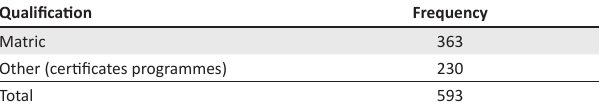
FIGURE 2: The distribution of participants by Municipality in percentage ( % ). TABLE 1: Distribution by